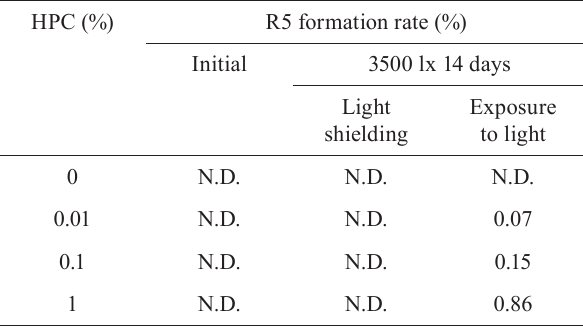
Table 7 R5 formation rate at different HPC